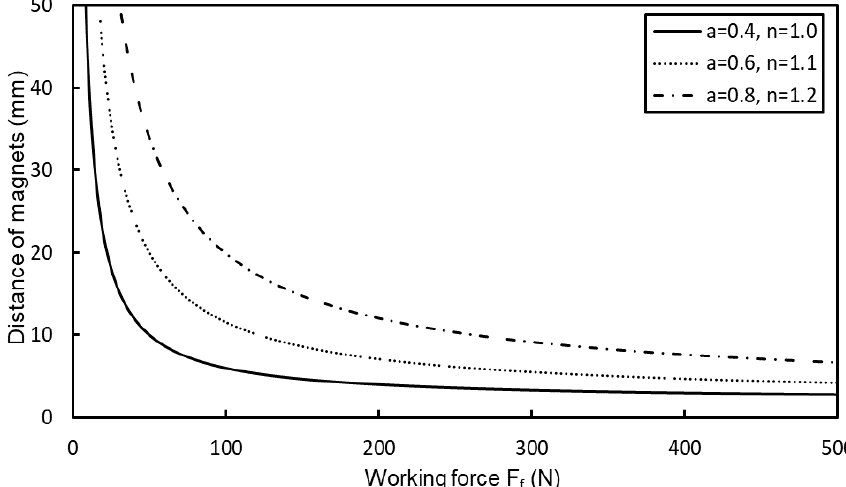
Figure 6. Graph showing the relationship between the preset distance between Permanent magnets (PMs) and the working force of the hydraulic cylinder.